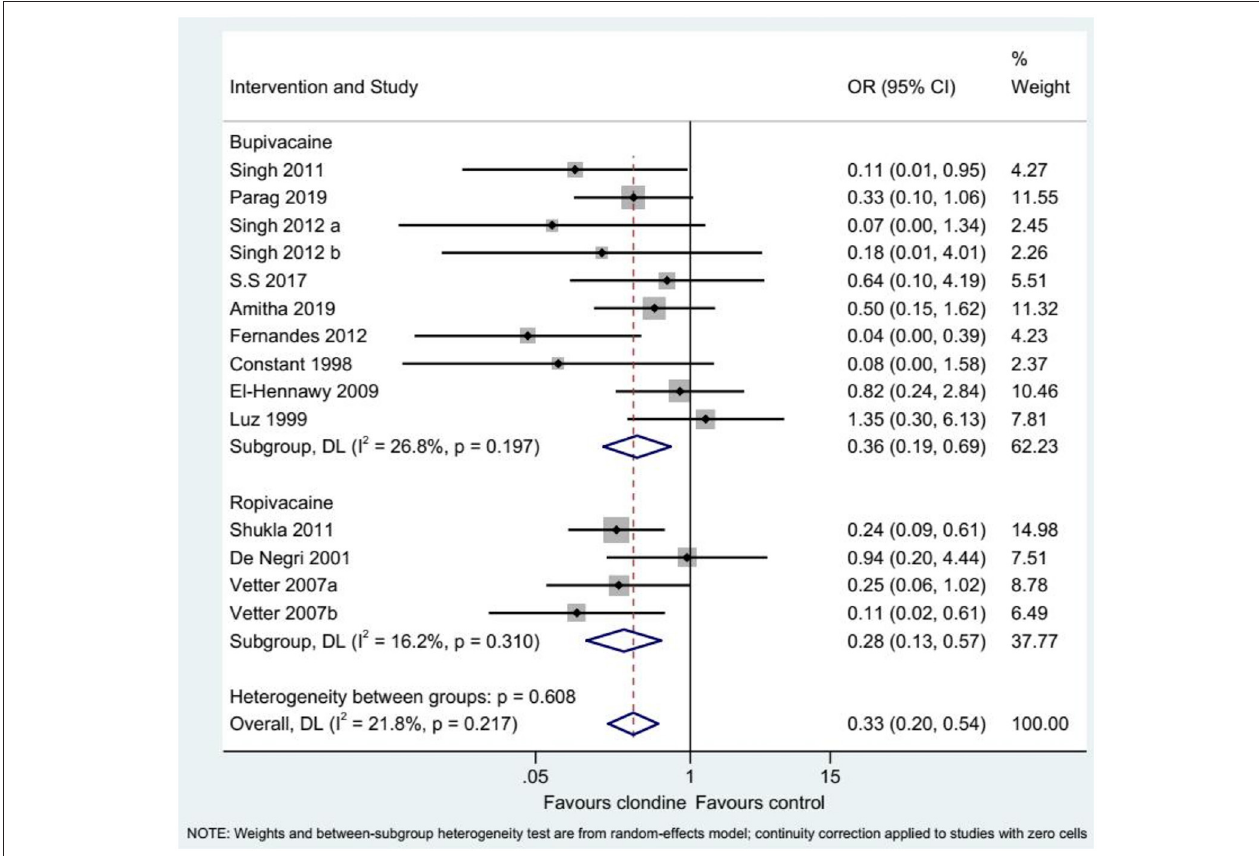
FIGURE 13 | Subgroup analysis of complications by local anesthetic.